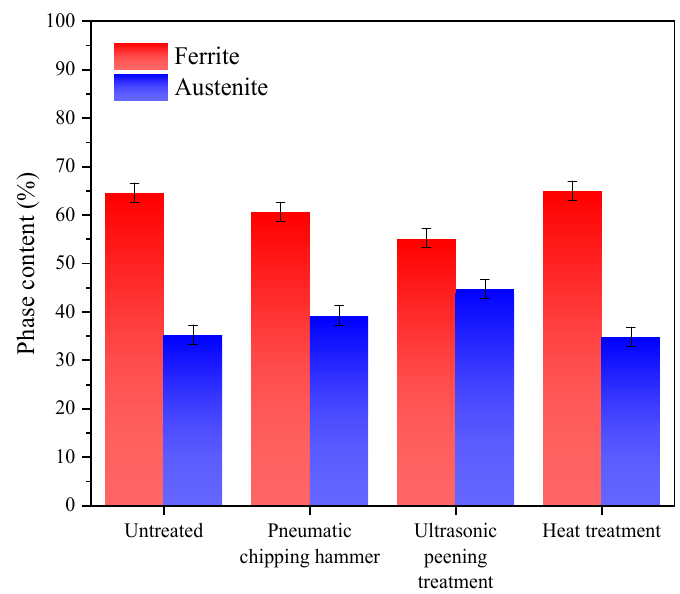
Figure 5. Ferrite and austenite content of DSS 2205 weld seam area with di ff erent treatments methods.